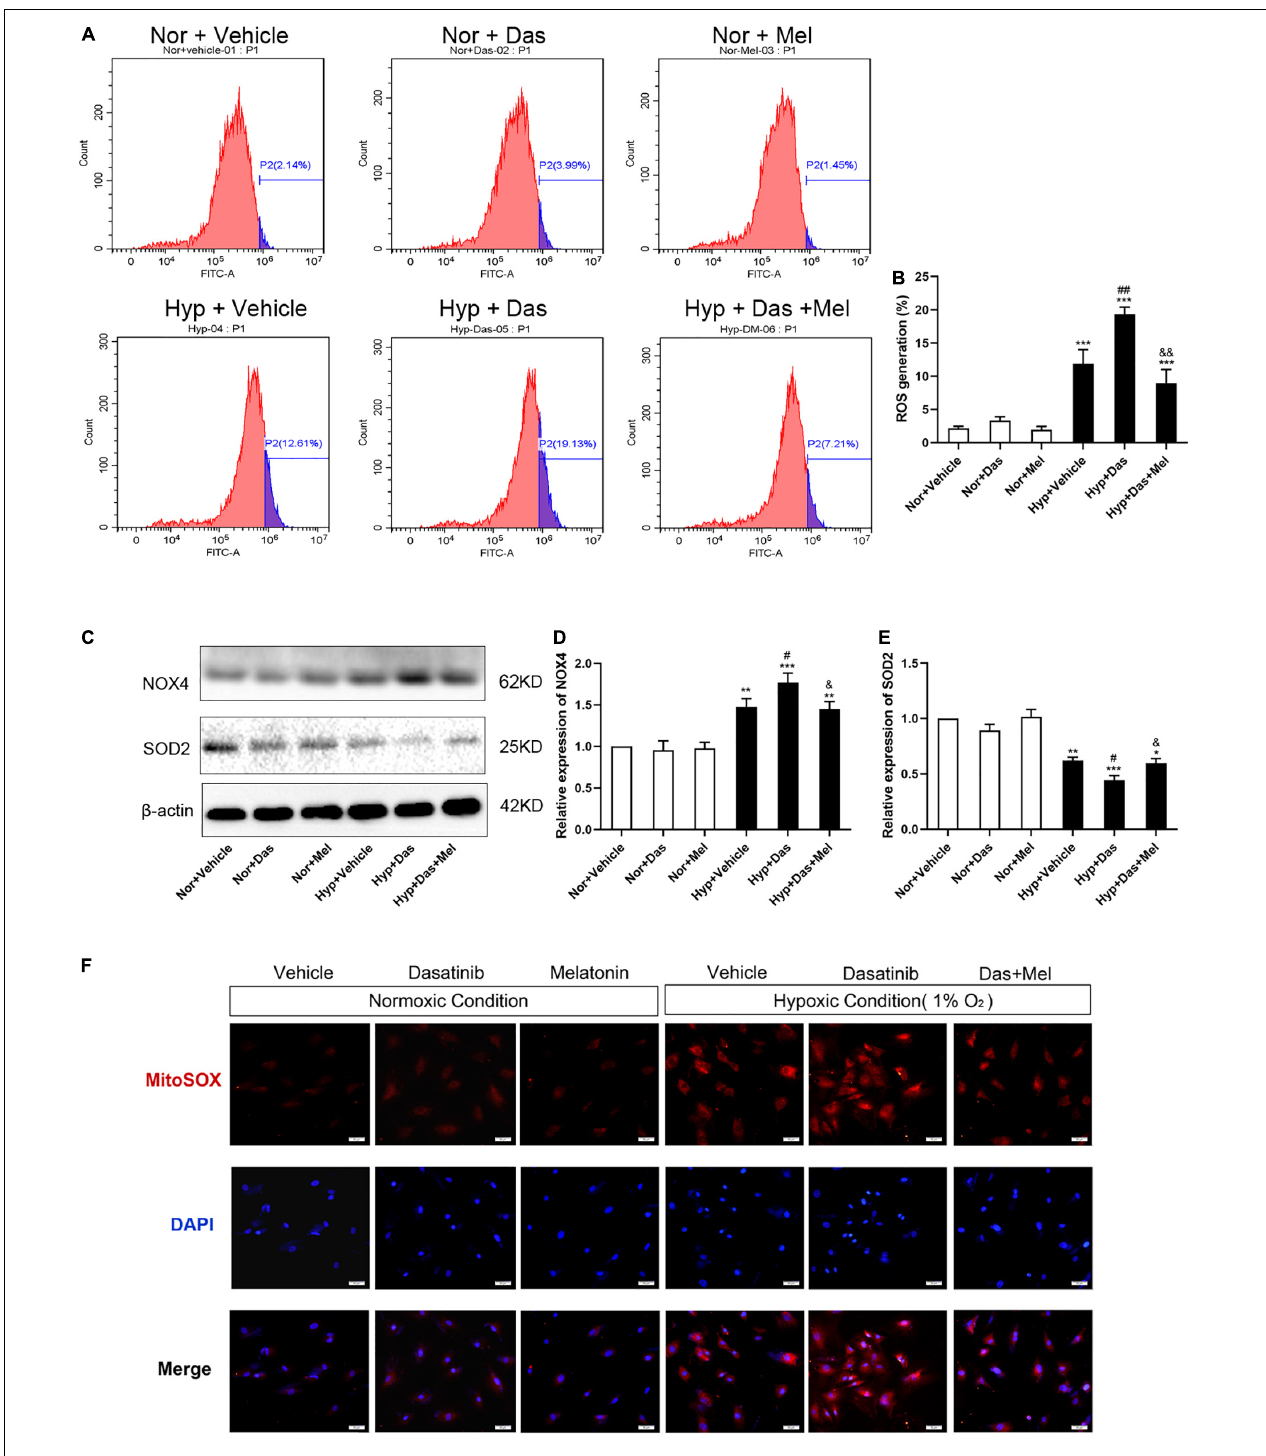
FIGURE 9 | Melatonin attenuates oxidative stress of pulmonary artery smooth muscle cells (PASMCs) induced by dasatinib under hypoxia in vitro . Flow cytometry analyses of PASMCs stained with 2, 7-dichlorodihydrofluorescein diacetate (DCFH-DA) (A) . A summary of intracellular ROS generation (B) ( n = 3). Protein expression of NOX4, SOD2 in PASMCs (C) . Bar graph shows the statistic results of NOX4, SOD2 protein levels (D,E) . Mitochondrial ROS with MitoSOX (in red), DAPI was used to label the nucleus (in blue), and the merged images of MitoSOX and DAPI were shown on the right (original magnification × 20, scale bars: 50 µ m) (F) . Values are means ± SEM, ***P < 0.001, **P < 0.01, *P < 0.05 compared with Nor + Vehicle group. ## P < 0.01, # P < 0.05 compared with Hyp + Vehicle group. && P < 0.01, & P < 0.05 compared with Hyp + Das group ( n = 3).